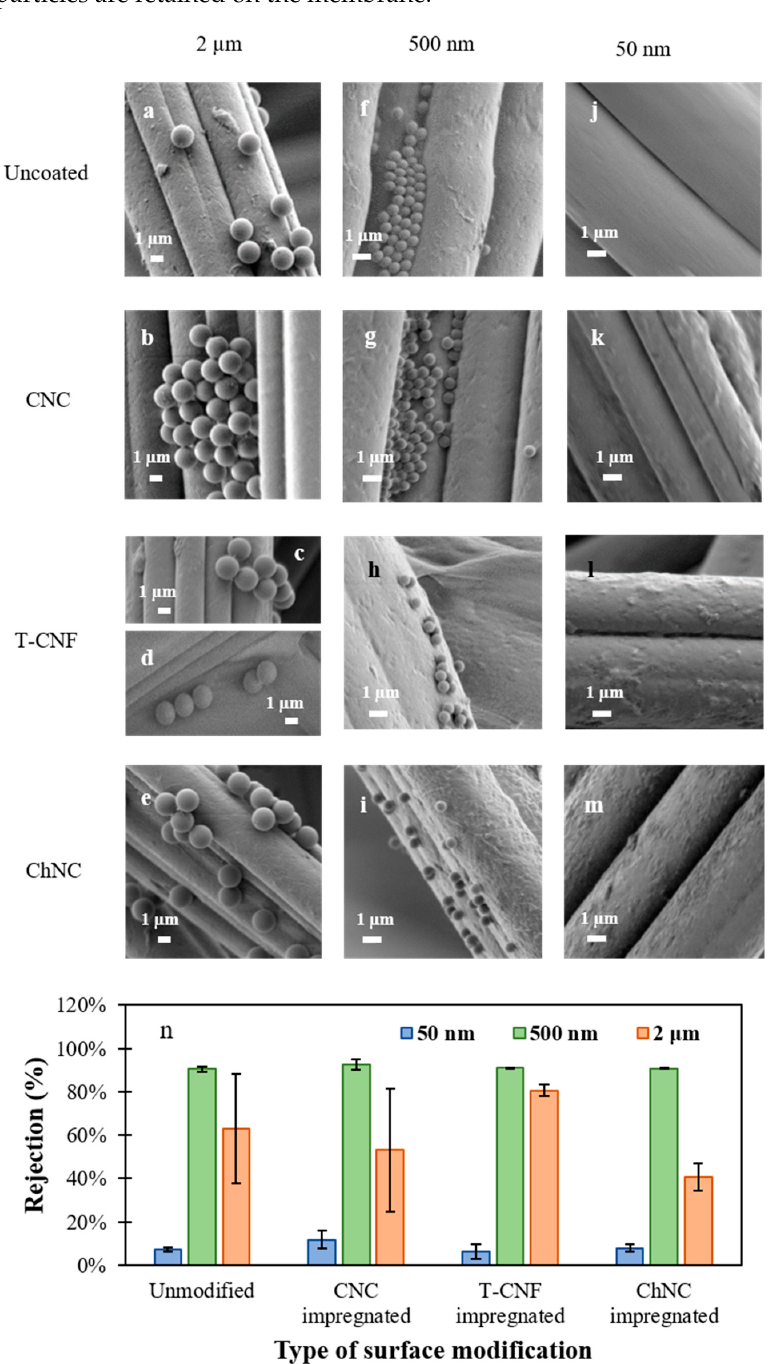
Figure 2. SEM images of unmodified and nonwoven fabrics after coating process, used for the particle retention performance study. For 2 µ m PS beads suspension: ( a ) unmodified nonwoven fabric, ( b ) CNC impregnated, ( c , d ) T-CNF impregnated, ( e ) ChNC impregnated; for 500 nm PS beads suspension: ( f ) unmodified nonwoven fabric, ( g ) CNC impregnated, ( h ) T-CNF